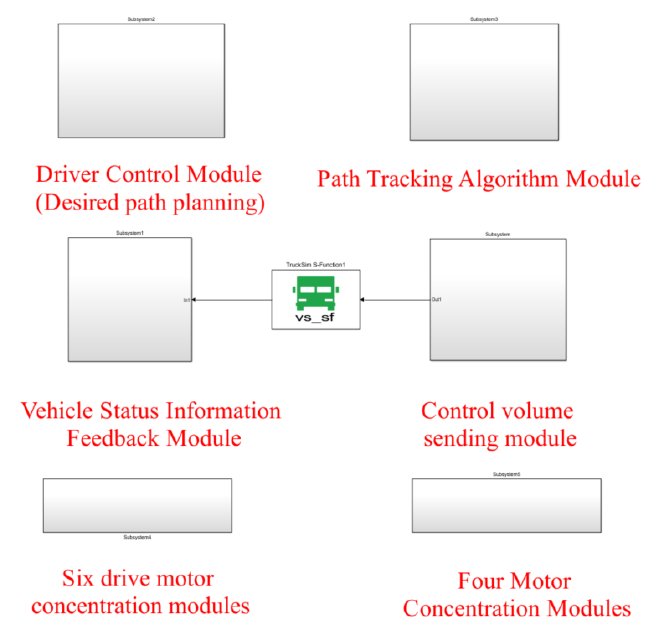
Figure 6. Simulation module under MATLAB/Simulink. Table 1. The main parameters of 6WID/4WIS UGV.